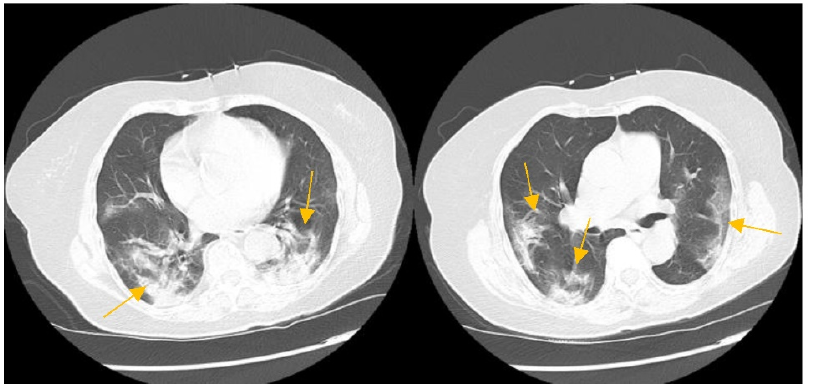
Figure 3. CT chest scan during active COVID-19 infection showing moderate multifocal areas of consolidation (yellow arrows).